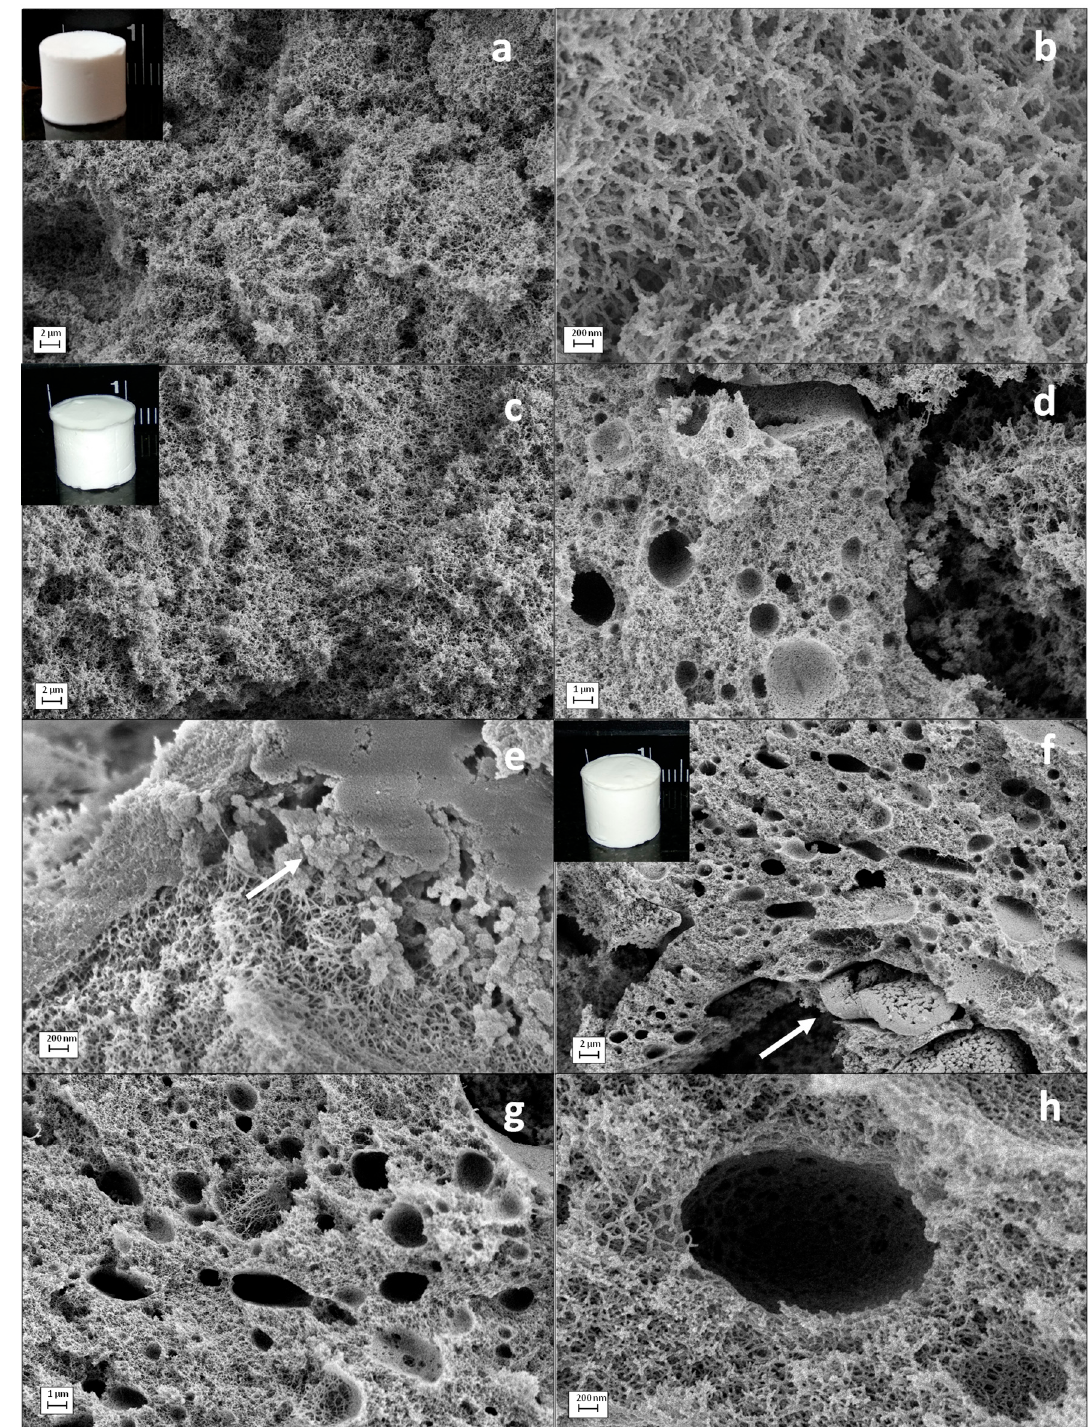
Figure 2. SEM images of cross ‐ sections of the starch aerogels. Characteristic fibrous starch network enlightened by zein ‐ free [Z0] aerogels ( a , b ). The porogen addition and subsequent removal caused larger and spherical pores along the inner aerogel architecture for ( c – e ) [Z1] and ( f – h ) [Z2] aerogel formulations. For these aerogels, residues from zein protein were present, suggesting an incomplete porogen removal ( e , f ; white arrow highlighting zein residues). Intakes: Visual appearance of starch aerogel cylinders ( a ) [Z0], ( c ) [Z1], and ( f ) [Z2], respectively. Material surface roughness and topography are amongst the physicochemical properties that conditions the adhesion of cells to the scaffolds among other cell functions [43,44]. A topography for scaffolds combining cells ‐ material contact at the microscale and nanoscale is necessary to reach